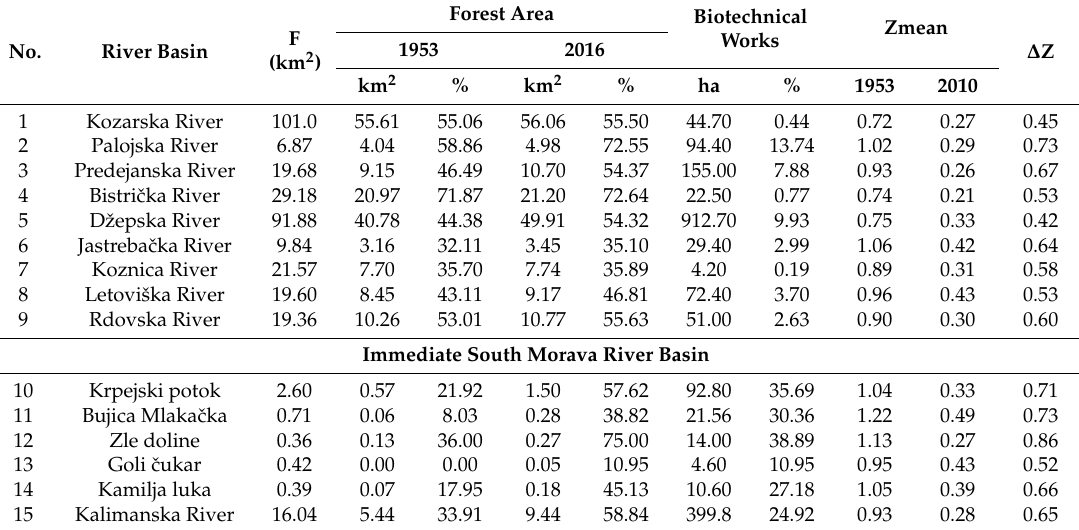
Table 7. Changes in the percentage of the forest area after ECW in Grdelica